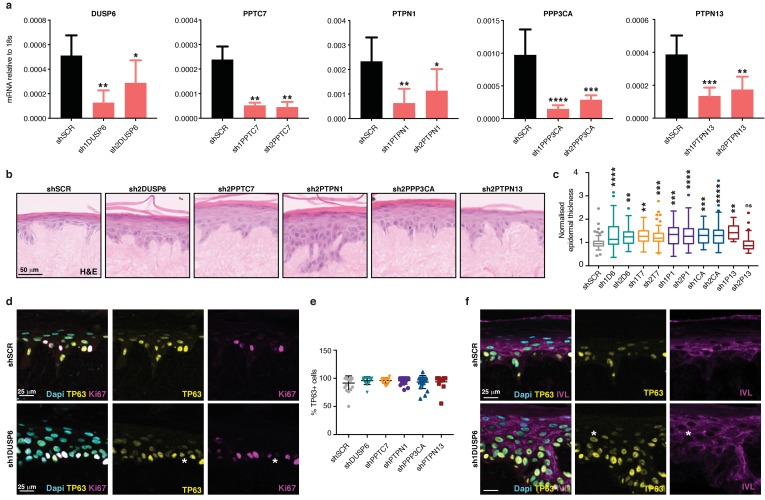
Effect of shRNA-mediated knockdown of the phosphatases on epidermal reconstitution.(a) RT-qPCR quantification of phosphatase mRNA levels relative to 18 s RNA upon knockdown by lentiviral-mediated shRNA one week after infection and selection. p-values were generated by one-way ANOVA. (b) Epidermal reconstitution following knockdown of DUSP6, PPTC7, PTPN1, PPP3CA or PTPN13. n = 2 independent infections. Representative H and E images. (c) Epidermal thickness was quantified in eight non-consecutive sections per biological replicate as explained in Figure 2—figure supplement 4 and normalised to shSCR values. p-values were generated by one-way ANOVA. (d) Representative images of epidermis reconstituted by keratinocytes expressing shSCR or sh1DUSP6 co-stained for TP63 (yellow) and Ki67 (pink) with DAPI nuclear counterstain (blue). White asterisk shows a TP63+ Ki67 cell. (e) % Ki67-labelled nuclei that were also TP63+ was quantified in n = 5 fields per replicate. p-values generated by one-way ANOVA were >0.05. (f) Representative images of epidermis reconstituted by keratinocytes expressing shSCR or sh1DUSP6 co-stained for TP63 (yellow) and IVL (pink) with DAPI nuclear counterstain (blue). White asterisk shows a suprabasal cell co-stained for IVL and TP63. a, c, e. Error bars represent s.d. *p<0.05; **p<0.01; ***p<0.0005; ****p<0.0001; ns = non-significant.